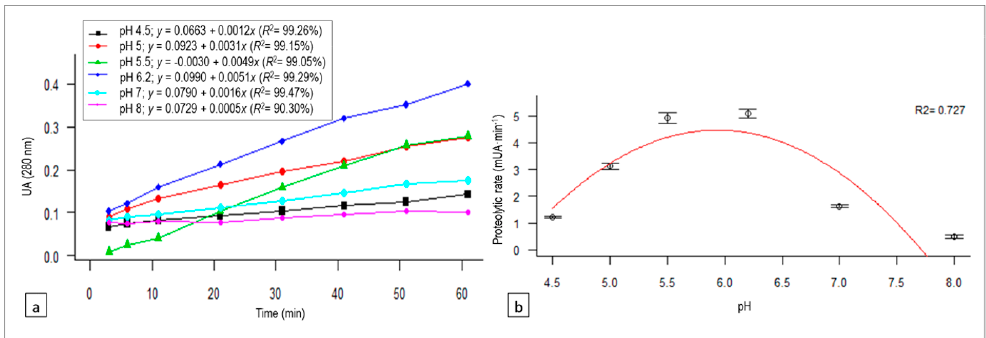
Figure 2. (a) Variation of absorbance (which correlates with proteolytic activity) with reaction time for each of the pH values tested, as well as their regression equations and determination coefficients ( R 2 ), for the proteolytic activity linear trend of the C. scolymus L. extract on bovine casein. (b) Quadratic regression model of the pH effect on the proteolysis rate of the C. scolymus L. extract on bovine casein.